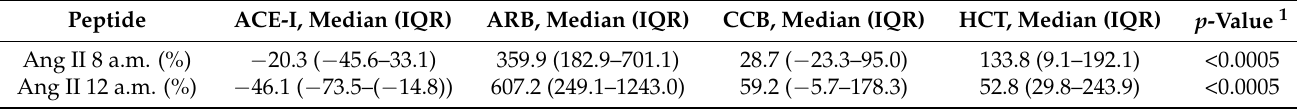
Table 5. Difference in Ang II equilibrium concentrations between baseline and after four weeks of treatment in the morning (8 a.m.) and at noon (12 a.m.), for each assigned drug, as percentage in comparison to baseline values, presented as median (IQR, p